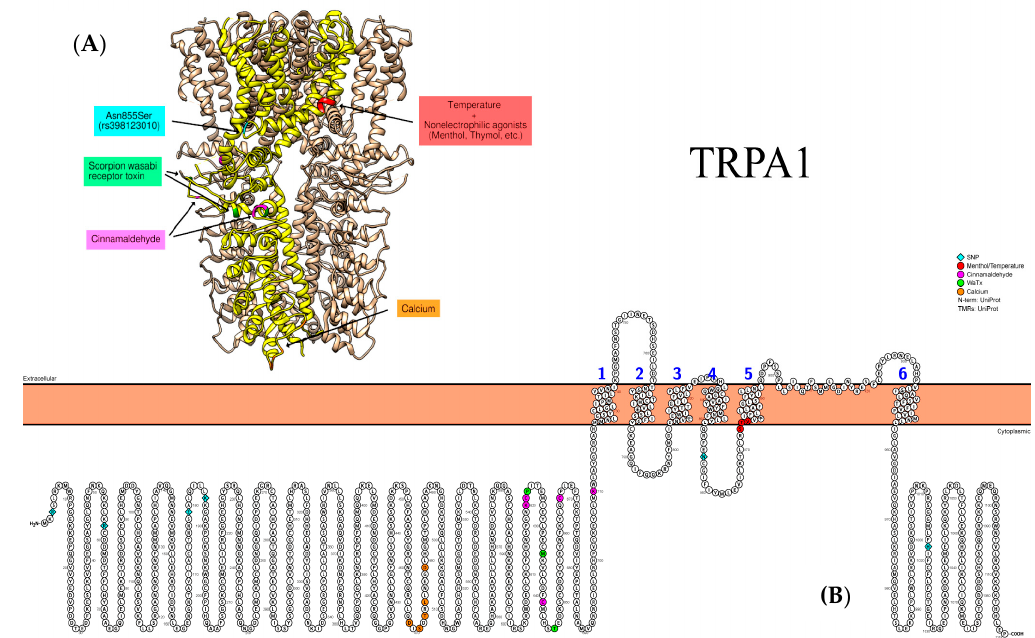
Figure 3. Representative structure of TRPV4 (PDB ID: 6BBJ) channel. ( A ) Individual subunit is highlighted in yellow. Not all known binding sites/SNPs are shown due to limited coverage of the currently available PDB models. ( B ) Relevant amino acid substitutions for SNPs in the coding regions of TRPV4: rs3742030 (p.Pro19Ser) and rs531738577 (p.Tyr491Ser).